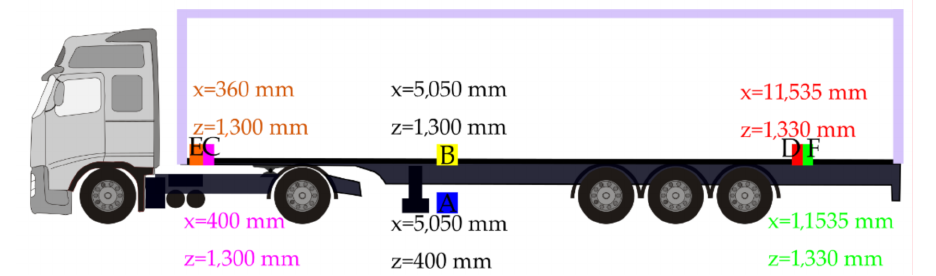
Figure 4. Sensor positions in case of Series 1 braking tests.